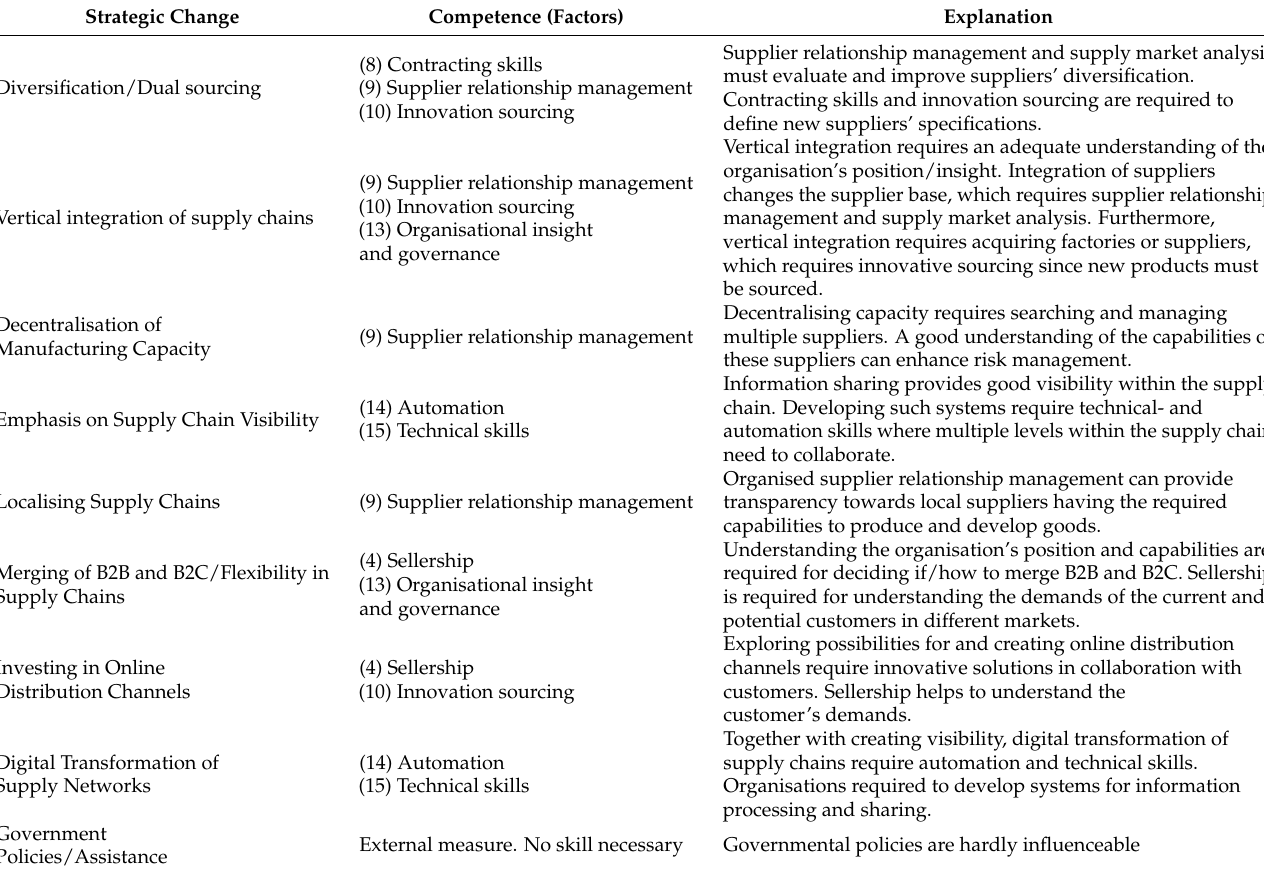
Table 3. Proposed required competences for each strategic